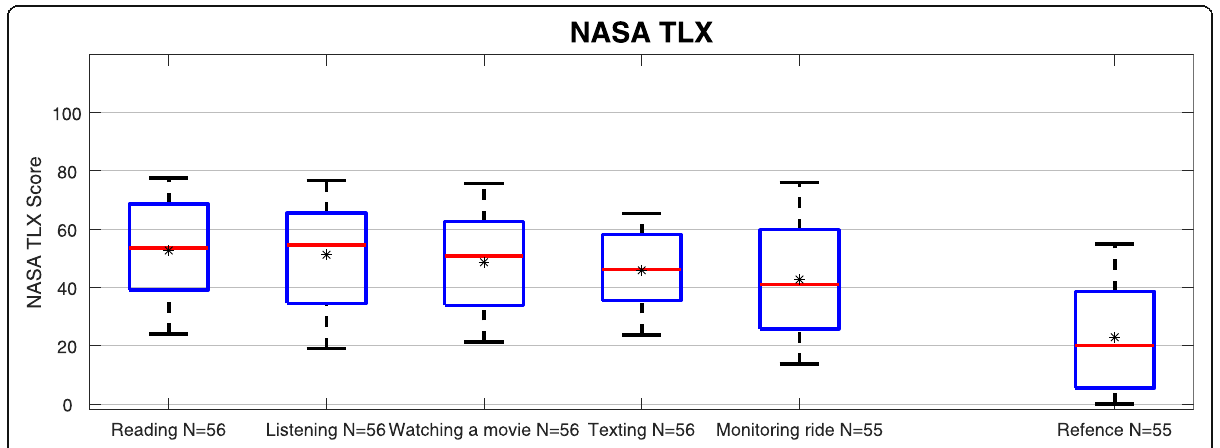
Fig. 5 Boxplot representation NASA-TLX - total score (weighted) depending on the examined NDRT in points